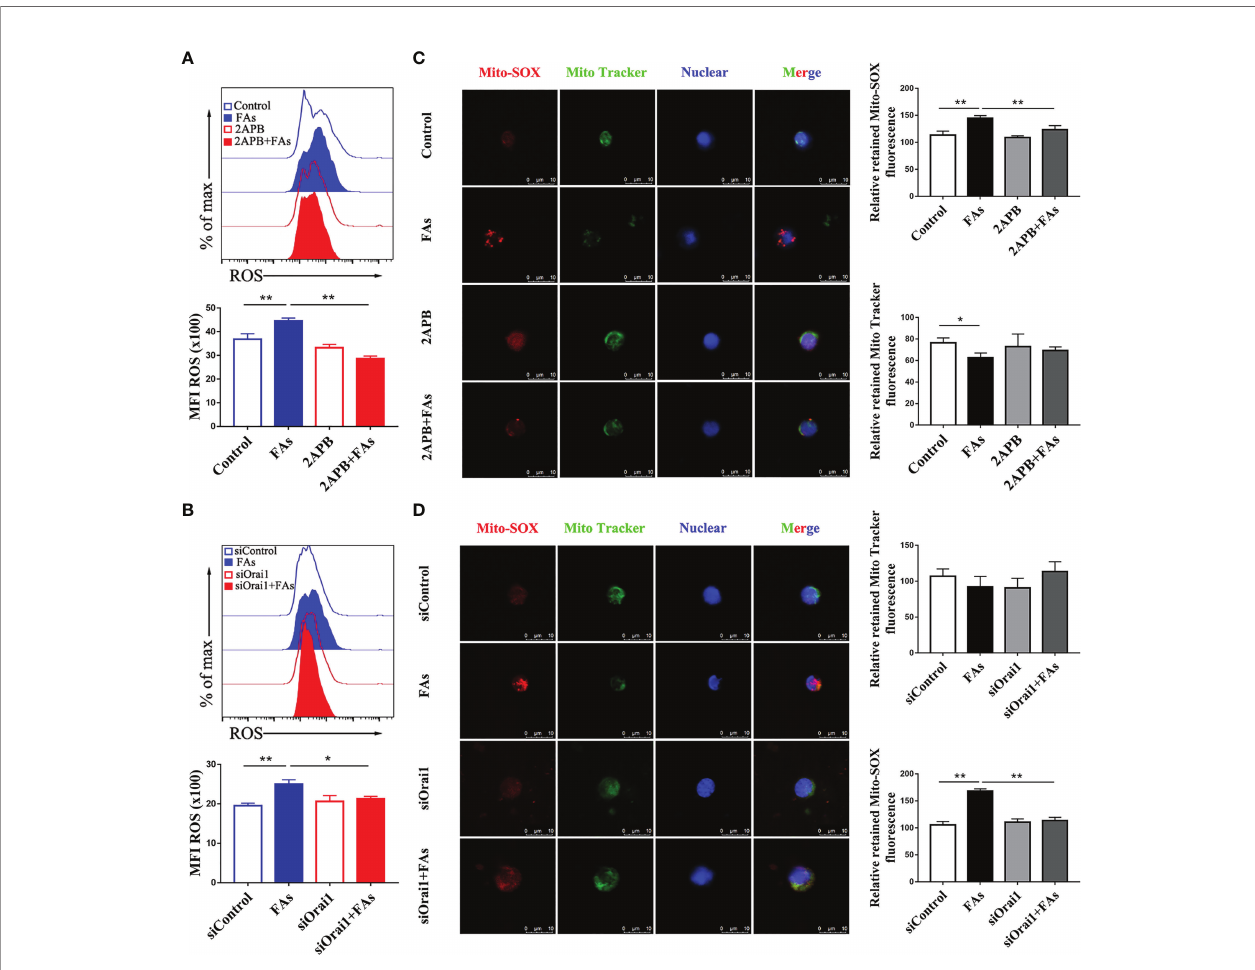
FIGURE 7 | Inhibition or silencing of ORAI1 relieved FAs-induce increased level of intracellular ROS and mitochondrial ROS in CD4 + T cells. CD4 + T cells were sorted from spleens from 1-d old calves and stimulated with 2APB or siORAI1 before FAs treatment with 12 h (A) Staining of intracellular ROS use DCFH-DA in stimulated with 2APB (n = 4 per group). (B) Staining of intracellular ROS use DCFH-DA in stimulated with siORAI1 (n = 4 per group). (C) Staining of mitochondrial ROS use Mito-SOX in stimulated with 2APB (n = 3 per group; 3 random fi elds per group; scale bars, 10 m m). (D) Staining of mitochondrial ROS use Mito-SOX in stimulated with siORAI1 (n = 3 per group; 3 random fi elds per group; scale bars, 10 m m). The data of the control were used to normalize other treatments. Comparisons among groups were calculated using a one-way ANOVA with a Duncan correction. The data presented are the mean ± SEM, *P ≤ 0.05, **P ≤ 0.01 indicate differences from control or FAs